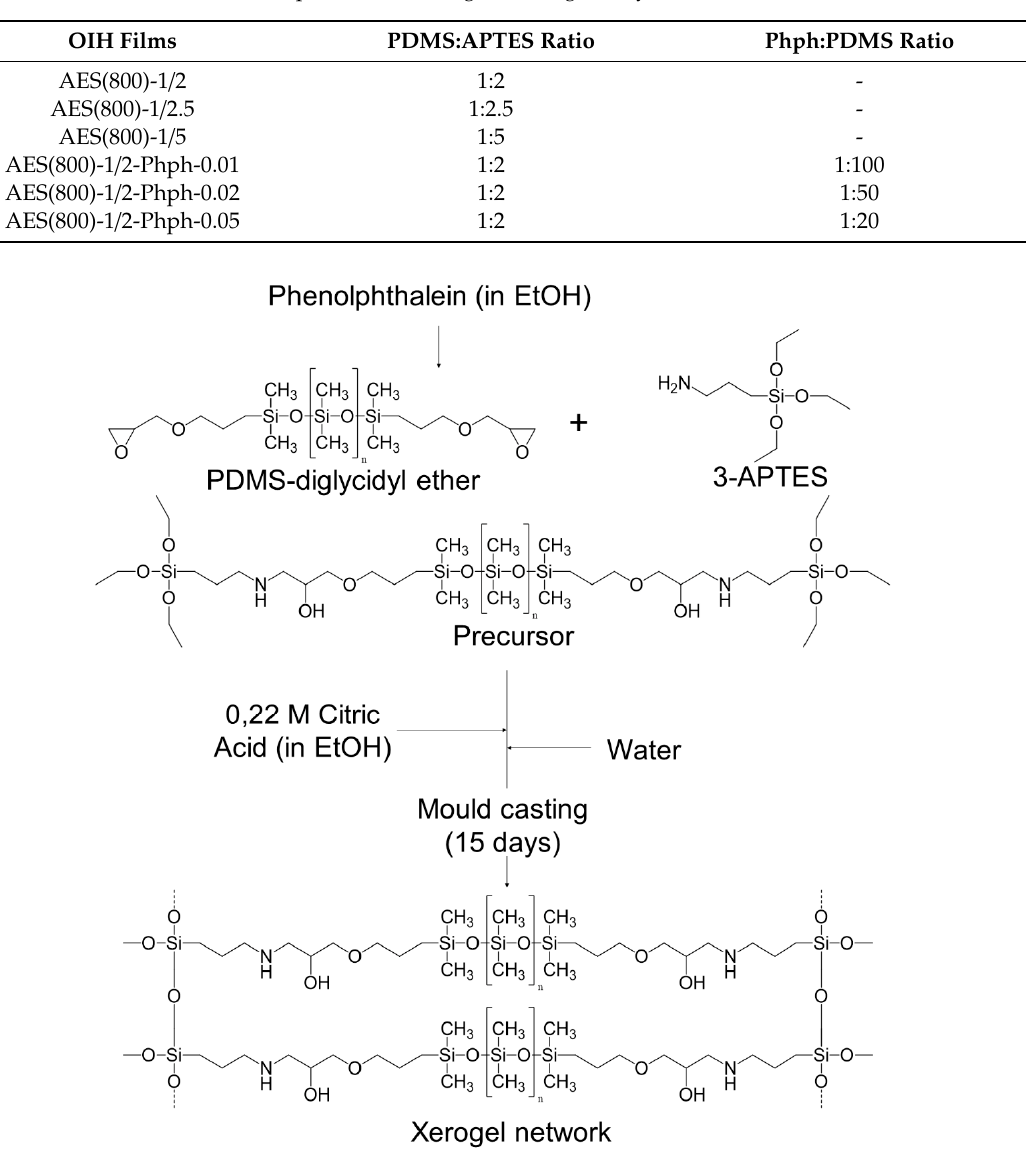
Table 1. Adopted codes for organic-inorganic hybrid (OIH) films.